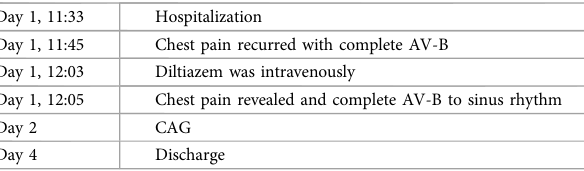
TABLE 1 Timeline of the case